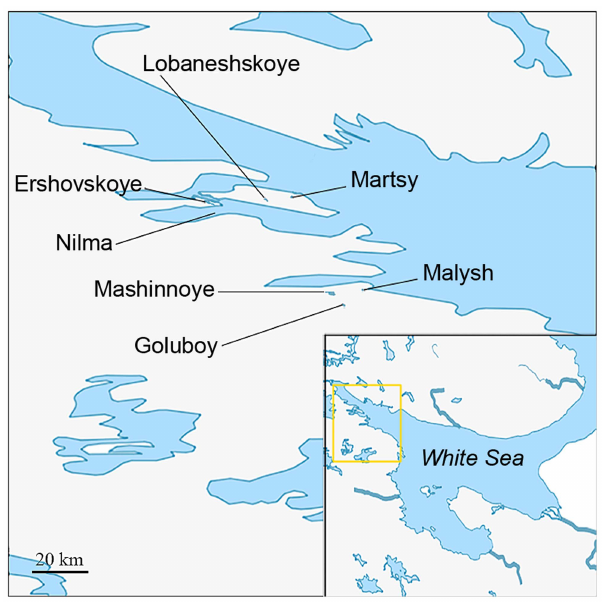
Figure 1. Map showing the locations of populations studied. Please see Table 1 for description of sampling sites.